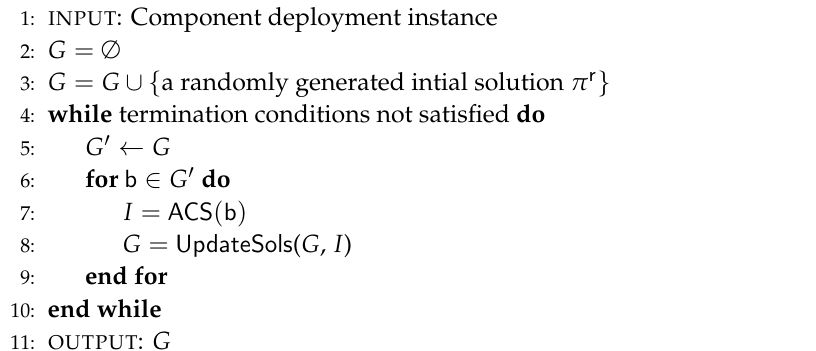
Algorithm 1 Ant Colony System for Multi-objective Component